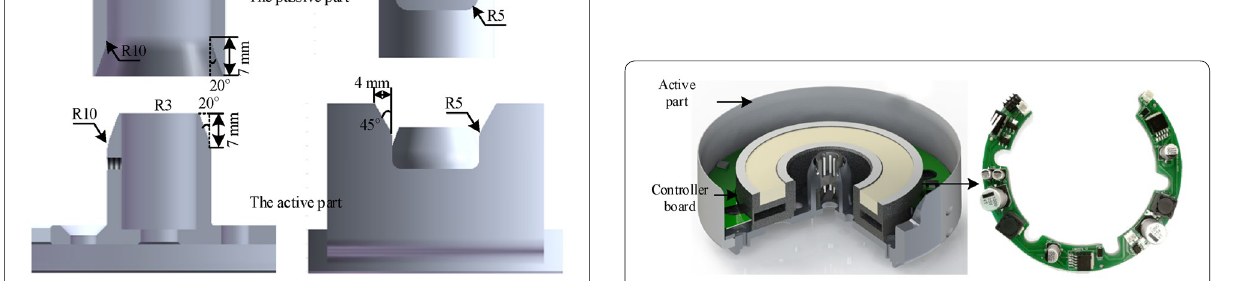
Figure 14 Tolerance designs of the RCM based on SMA